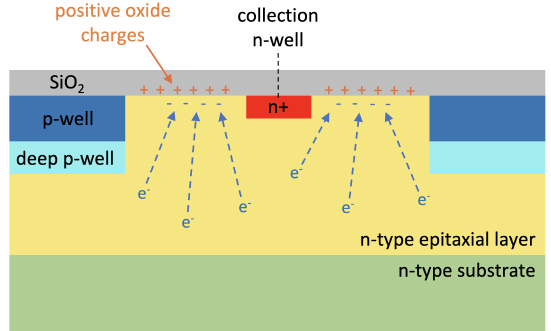
Figure 14. Schematic illustration of the electron accumulation in the gap between the collection n-well and the surrounding p-wells due to the positive oxide charges introduced at the Si-silicon dioxide (SiO 2 ) interface.